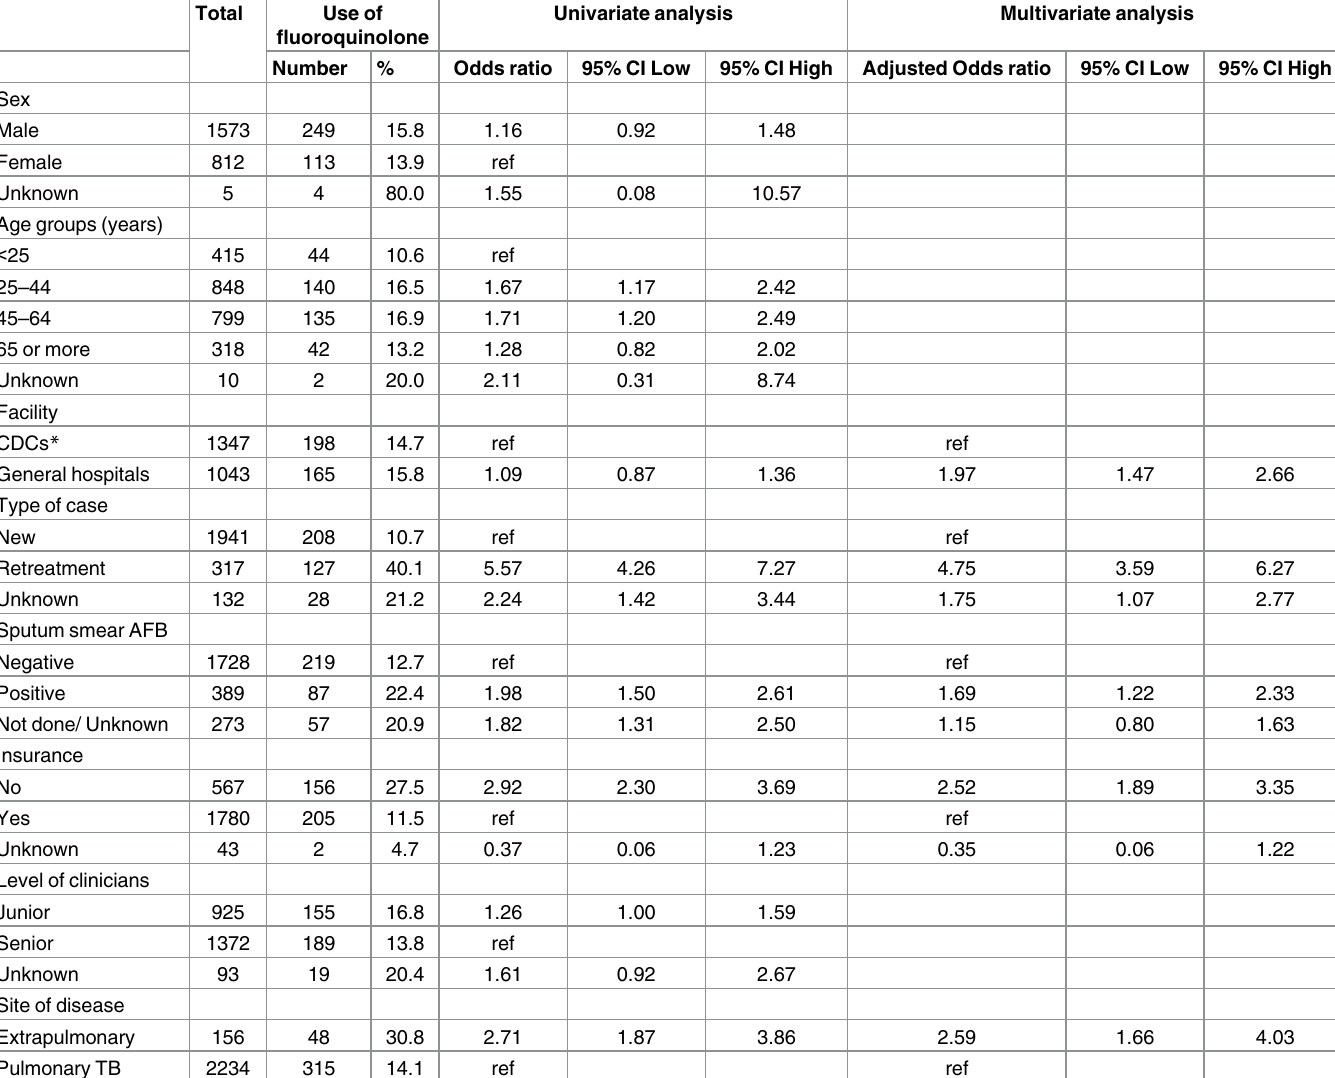
Table 3. Factors associated with the use of fluoroquinolone in the treatment of new and retreatment tuberculosis cases,